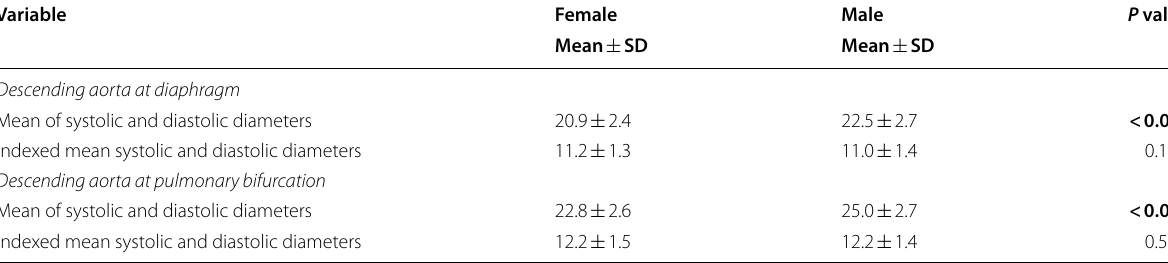
Table 16 Comparison of descending aortic diameters according to gender